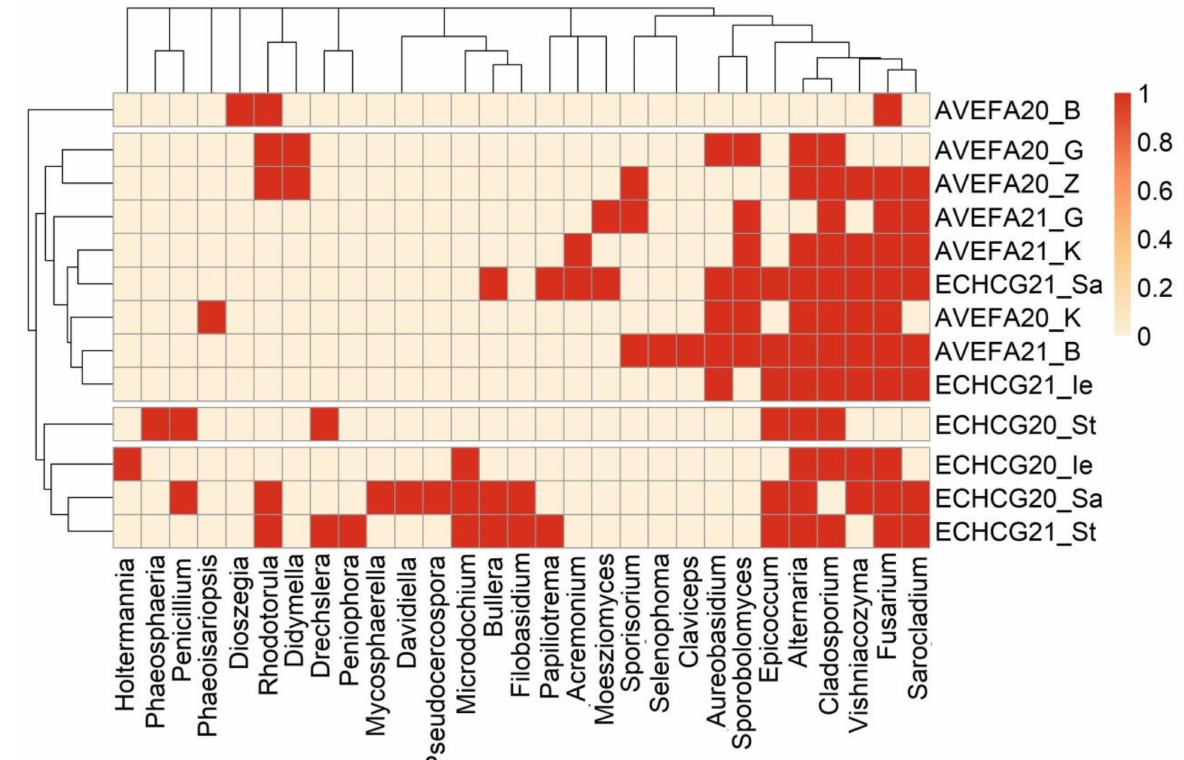
Figure 3. Hierarchical cluster diagram and heatmap based on Jaccard distances between fungal communities isolated from A. fatua (AVEFA) and E. crus-galli (ECHCG) seed samples collected in 2020 and 2021 in different locations (indicated by letters).